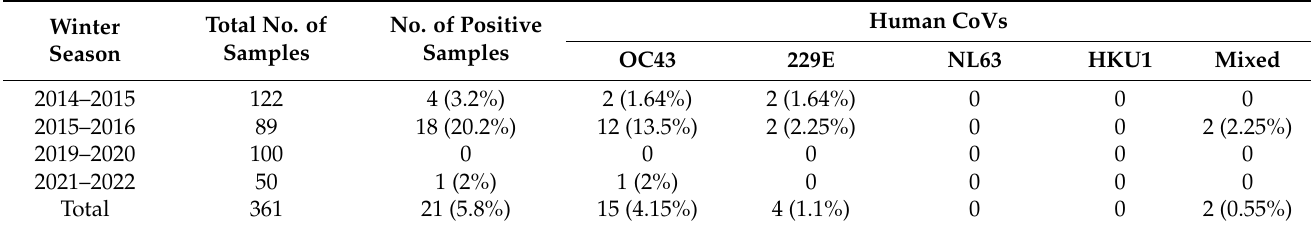
Table 2. The prevalence of the four common HCoVs in the studies of winter